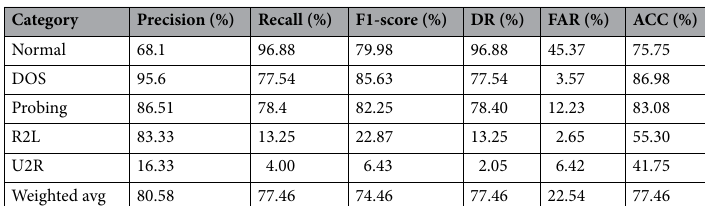
Table 7. Performance of proposed method on KDDTest+ dataset.